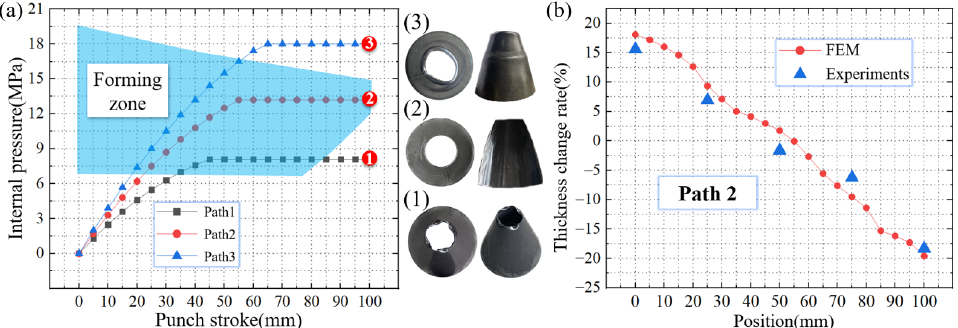
Figure 25. Rocket nozzle making by TUBG and its thickness value. ( a )The forming zone and rocket nozzle making by TUBG, ( b ) The wall thickness of the perfect nozzle.